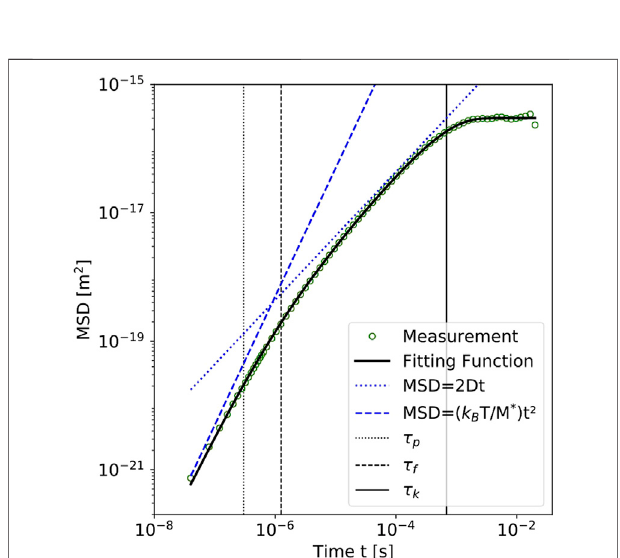
FIGURE 5 | Mean squared displacement for the 2 . 15 μ m diameter polystyrene particle covered with gold nanoparticles (AuPS) at an ambient temperature of T 0 (cid:2) 23 . 5 ° C. The vertical black lines denote the characteristic time constants of a Brownian particle in the trap. The momentum relaxation time τ p (cid:2) M / ( 6 πη R ) (cid:2) 300 ns, τ f (cid:2) 1251 ns and τ k (cid:2) 6 πη R / k (cid:2) 683 μ swhichisthetimefortheparticletomovethroughthetrapfromoneside to the